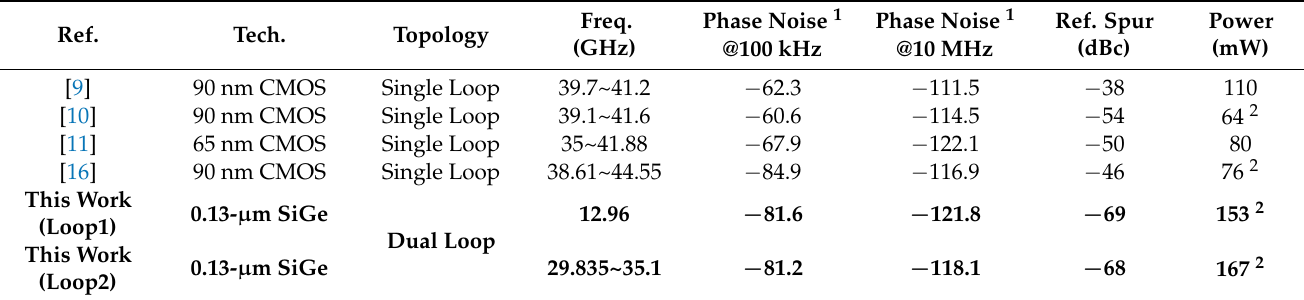
Table 1. Comparison of state-of-the-art frequency synthesizers for